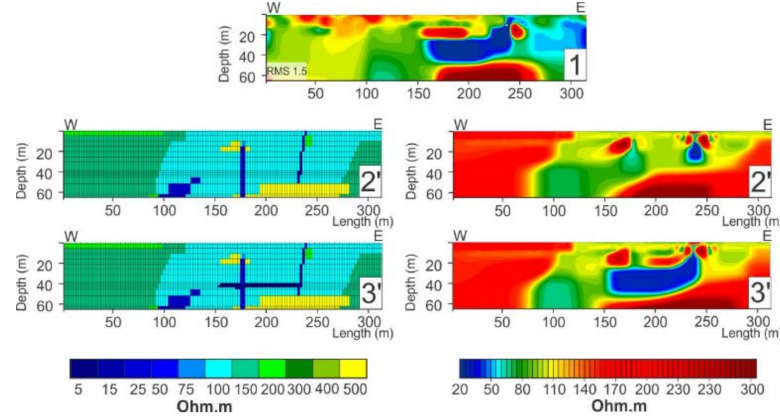
Figure 12. 2D modelling of resistivity data of Profile 2 (1) with Res2DMOD [54]. Inversion of the two parallel lodes model (2) and the horizontal lode model (3) are represented at (2 (cid:48) ) and (3 (cid:48) ), respectively. As seen in (2 (cid:48) ), the only presence of two conductive lodes, as supposed in the 3D model, cannot reproduce the low resistivity anomaly (1). The presence of a horizontal conductive layer between the two vertical lodes (3) is more appropriate to explain the geophysical signature of (1).